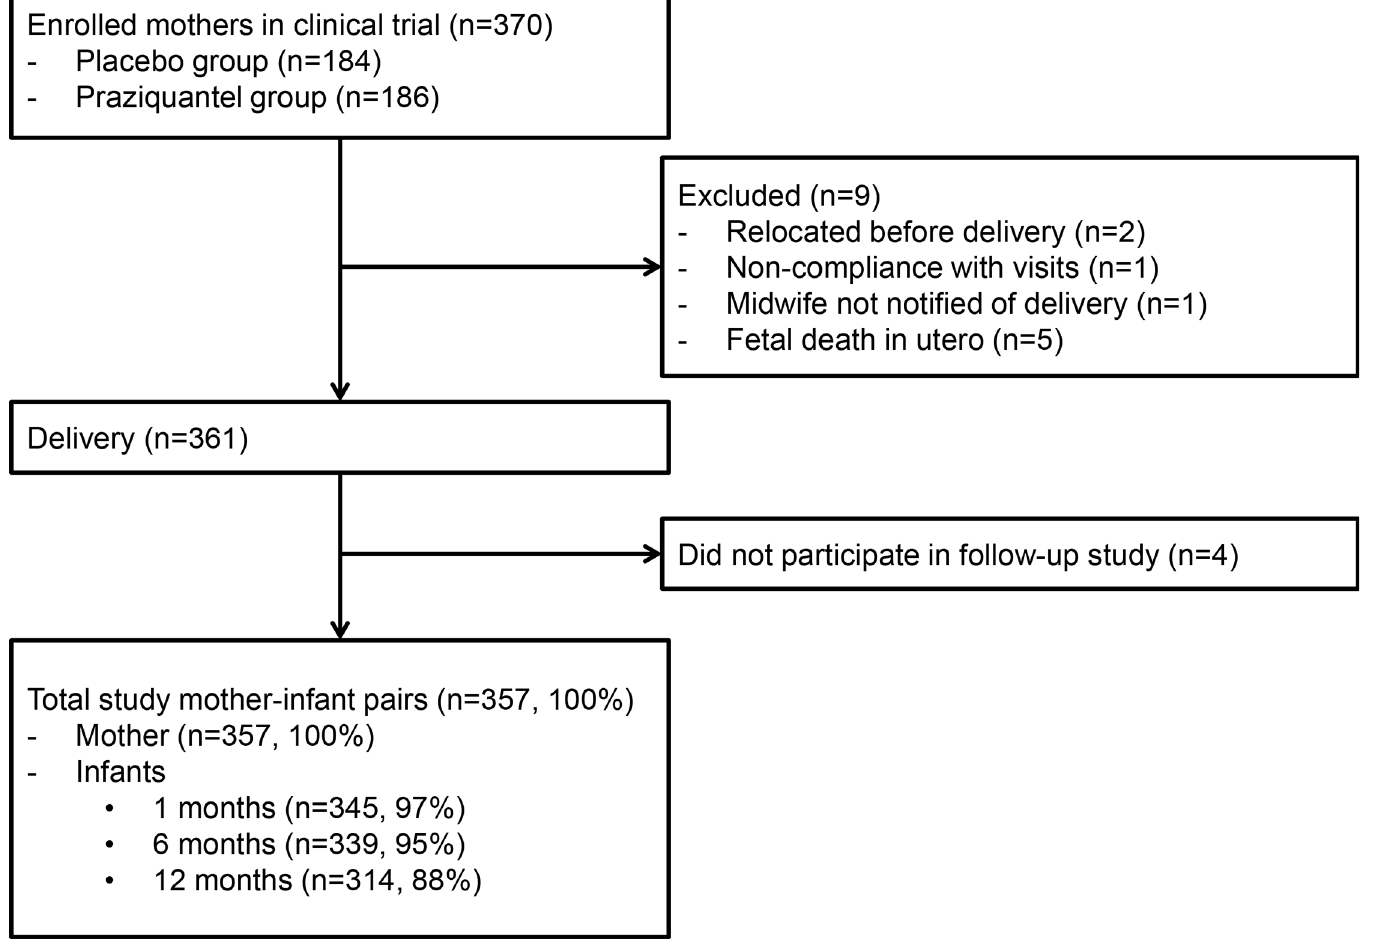
PLOS ONE | DOI:10.1371/journal.pone.0159461 July 21,